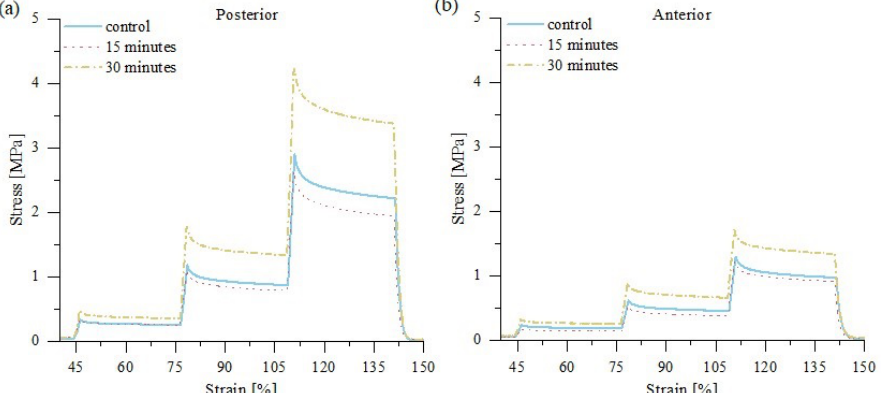
Figure 4. Mean stress-time relaxation curves after 0, 15, and 30 of drying for ( a ) posterior tendon fascicle bundles; ( b ) anterior tendon fascicle bundles. Visible increase in stiffness for both posterior and anterior samples; n =